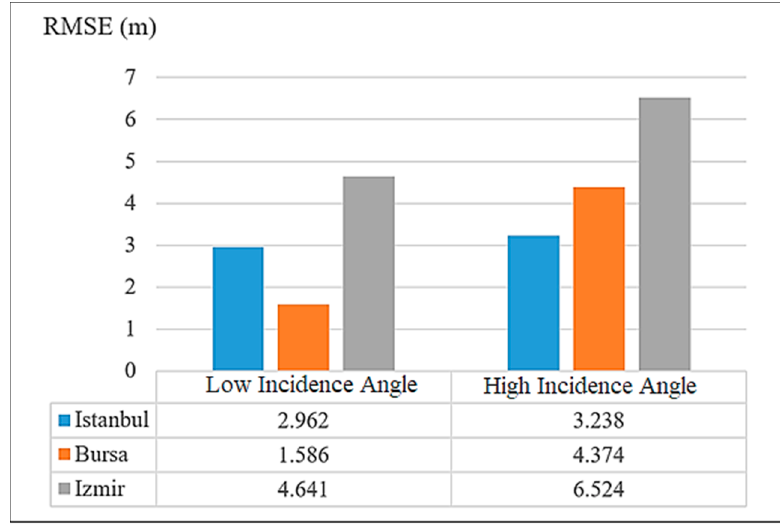
Figure 7. Accuracy of the results obtained using the original RPC model.